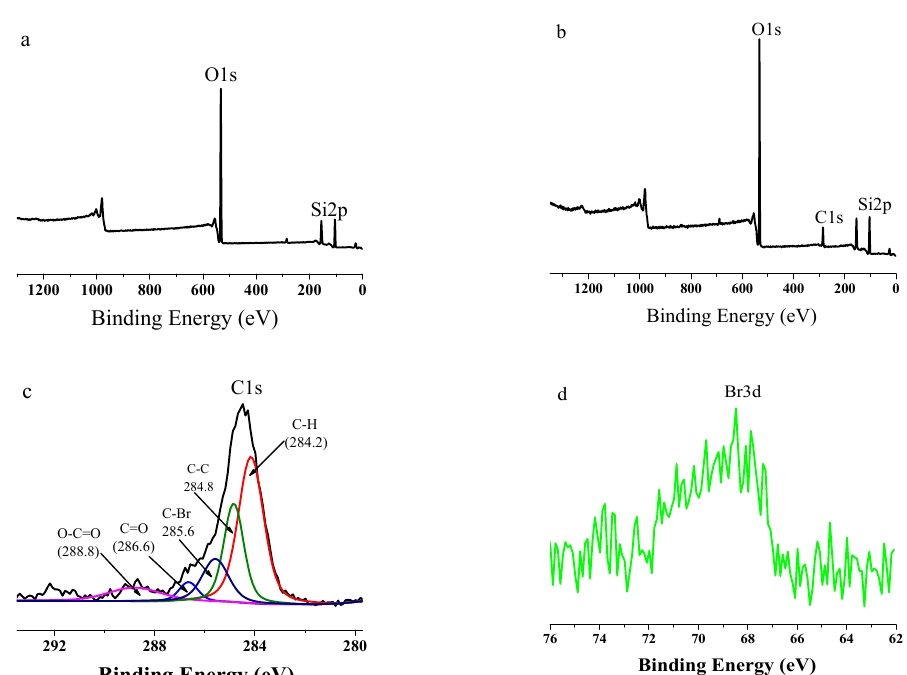
Figure 1. X-ray photoelectron spectroscopy (XPS) spectra of HS ( a ) and HS-Br ( b – d ): Survey scan curves range from 0 to 1350 eV ( b ), the C1s core-level spectra ( c ) and Br3d region ( d ).